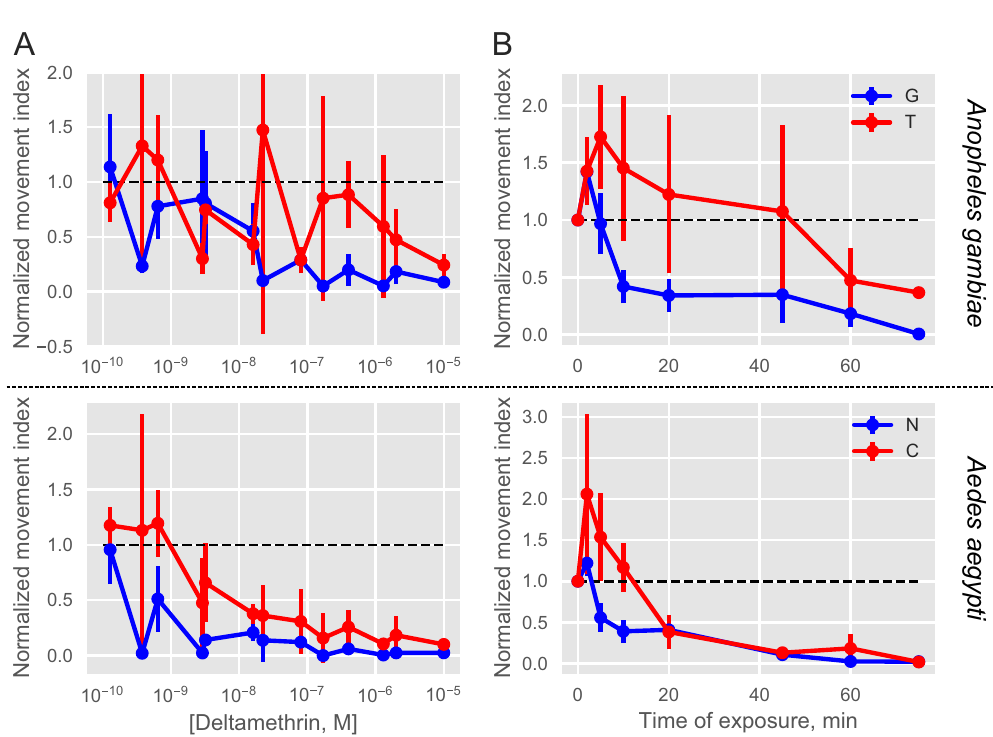
Fig 3. Motility measurement following deltamethrin exposure in concentration- and time-dependent manner for An . Gambiae susceptible (G3) and resistant (Tiassale) strains as well as for Ae . Aegypti susceptible (New Orleans) and resistant (Cayman) strains. The normalized movement index, which is the movement index (see Methods) divided by the index recorded before the application of insecticide, is plotted against the concentration after 60 min applications (A) and the time following exposure (B) to 10 − 6 M deltamethrin. Increased rate of movement inhibition is apparent in the larvae from adult susceptible strains (blue: G3 (G), New Orleans (N)) as compared to the adult resistant strains (red: Tiassale (T), Cayman (C)). The dotted line indicates the value before insecticide application. Error bars indicate ± 1 s.e.m. constant movement index over the duration of the recording (Fig 5A and 5B, dotted lines). In the presence of 1 × 10 − 6 M deltamethrin, the movement index began to fall after about 500– 1000 s to a steady-state, low level. The rate of this decline was slower for larvae from resistant strains ( k (= 1/ τ ) = 0.18 ± 0.08 x 10 3 s -1 for Cayman and 3.5 ± 0.16 x 10 3 s -1 for Tiassale) than it was for larvae from susceptible strains ( k = 2.7 ± 0.2 x 10 3 s -1 for New Orleans and 12 ± 2.3 x 10 3 s -1 for G3 – Anopheles : one-tailed unpaired t-test T(4) = 6.6, P = 0.011; Ae . aegypti : one- tailed unpaired t-test T (4) = 19.8, P < 1.9x10 -5 ). Thus, we detected the differential response of